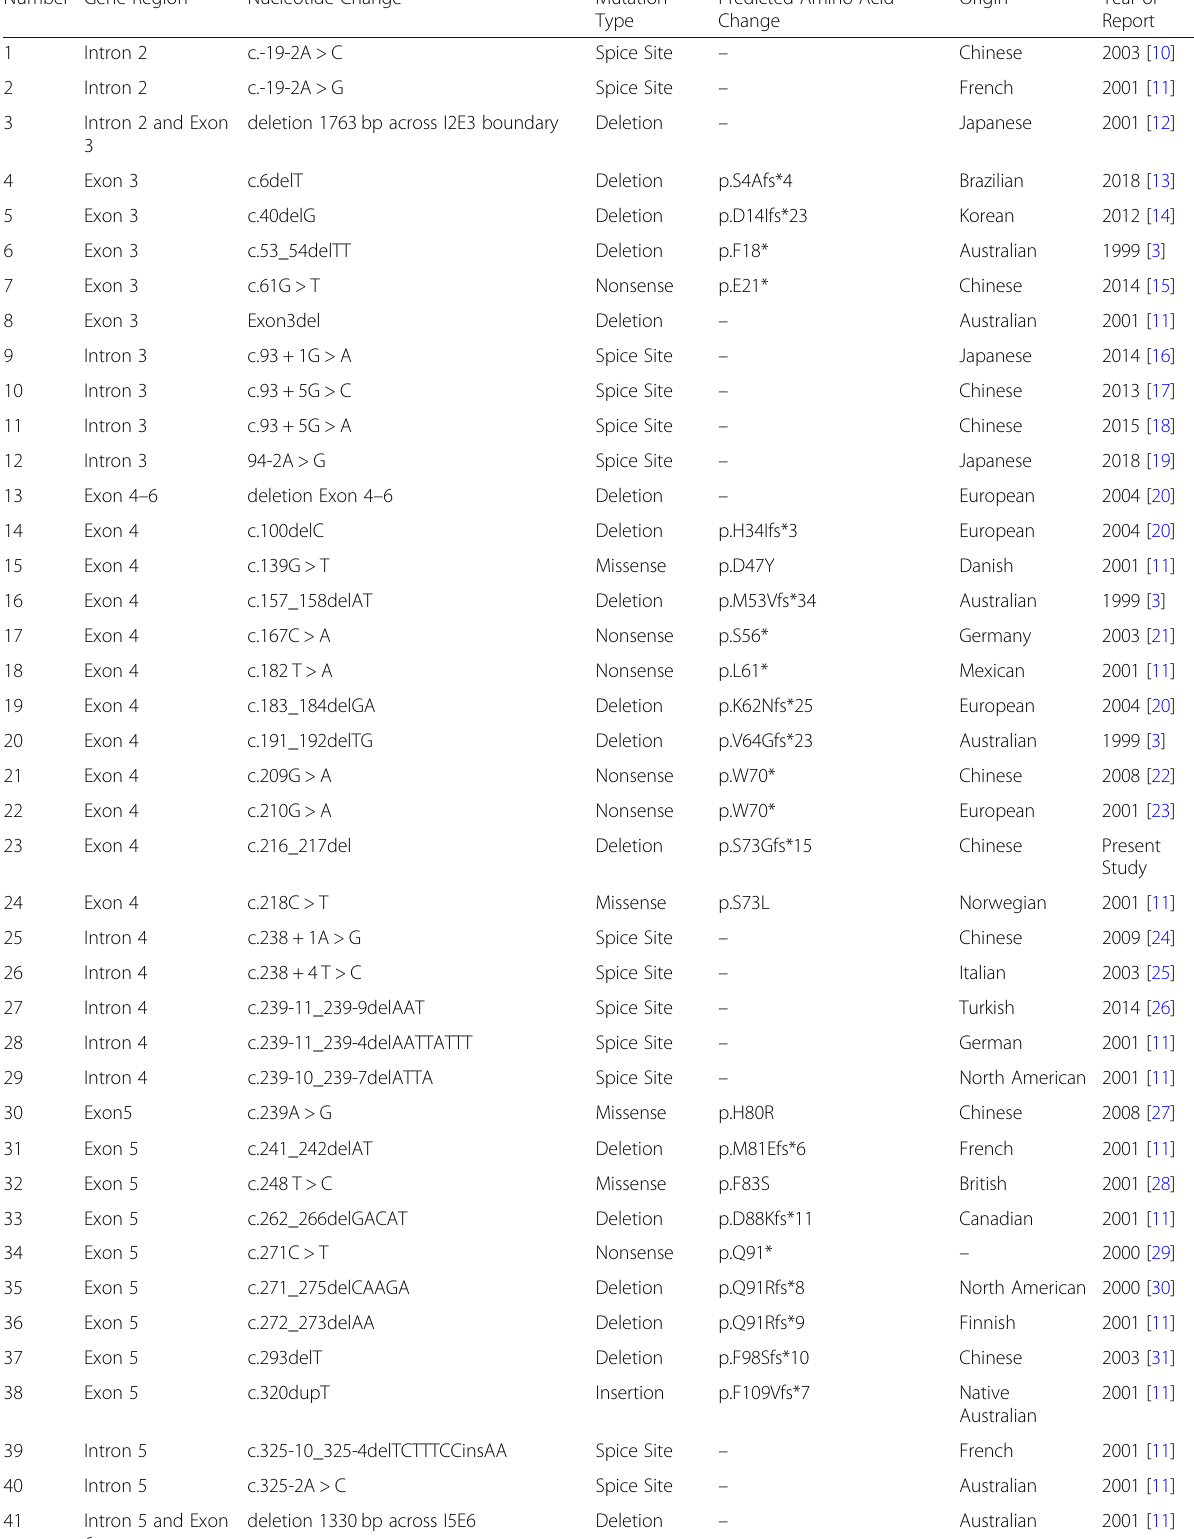
Table 1 Summary of identified pathogenic variants in the TRAPPC2